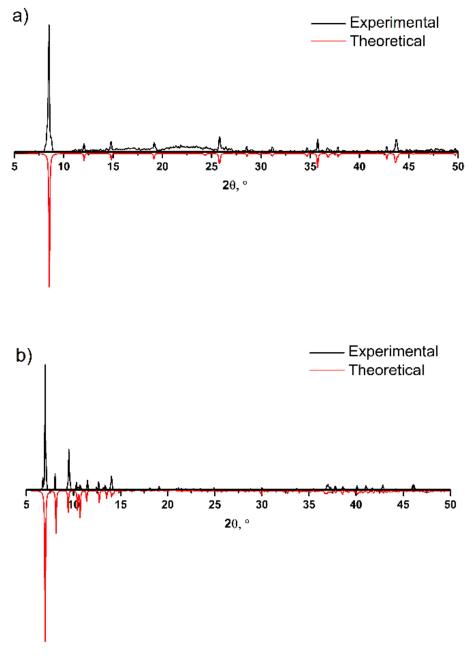
Figure 1. Experimental (top) vs calculated (bottom) powder di ff raction patterns for compounds 4 ( a ) and 5 ( b ).